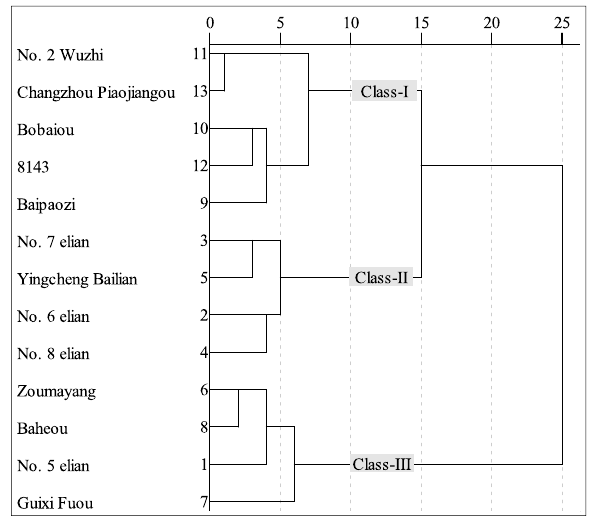
Table 7. Phenolic contents and antioxidant activities of three classes of lotus root.